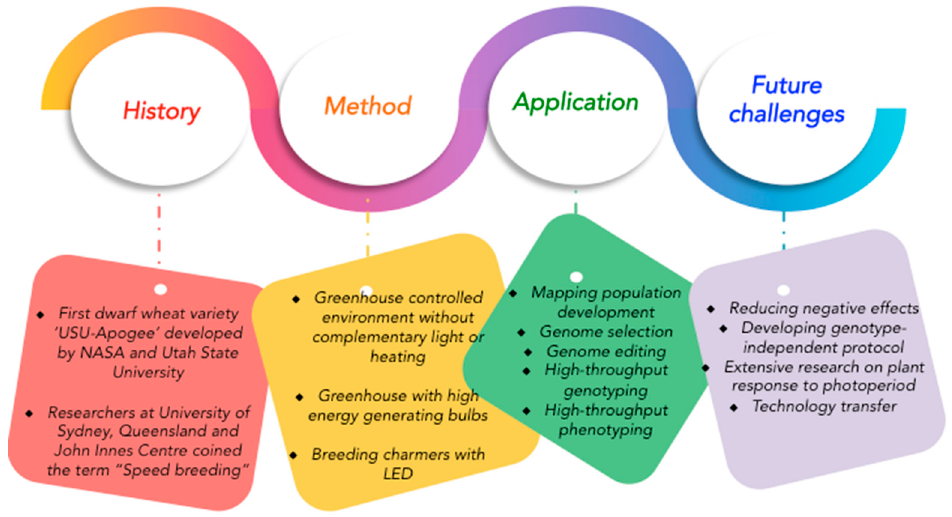
Figure 3. Retrospect, current methods, applications, and challenges of speed breeding .